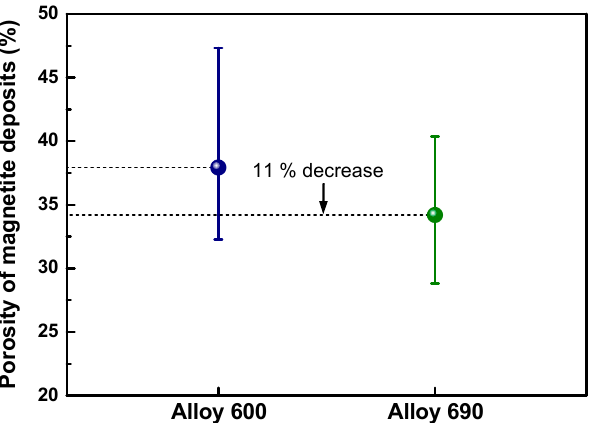
Figure 11. Porosity of magnetite deposits on SG tubes obtained using an image analyzer.